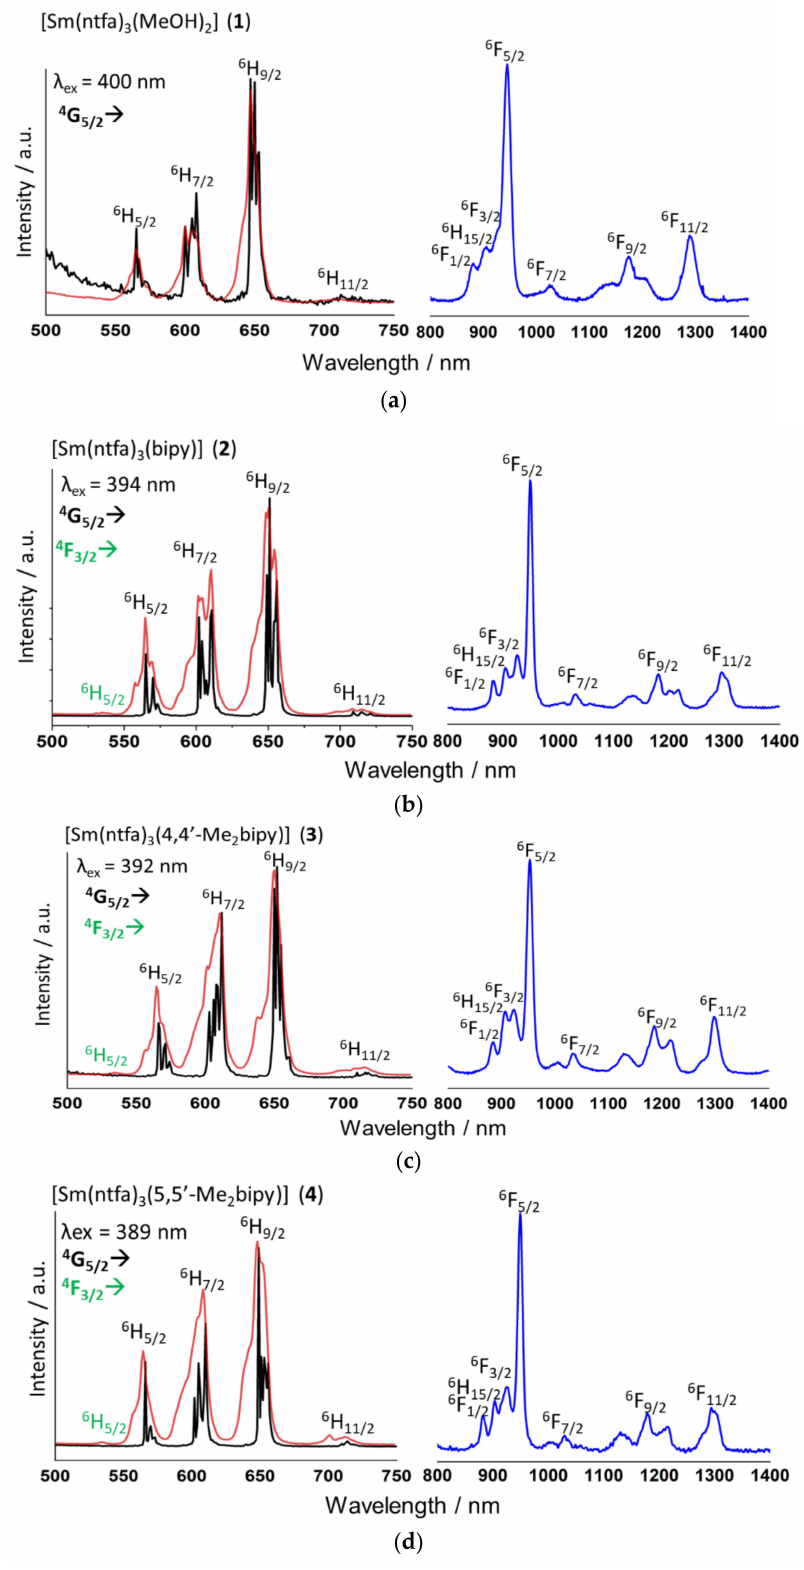
Figure 3. ( a – d ) The solid-state emission spectra of compounds 1 – 4 in the visible (red color at room temperature and black at 77 K) and NIR (blue color at 77 K)